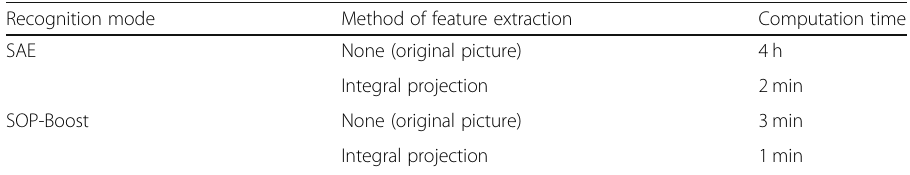
Table 6 The comparison of computation time Recognition